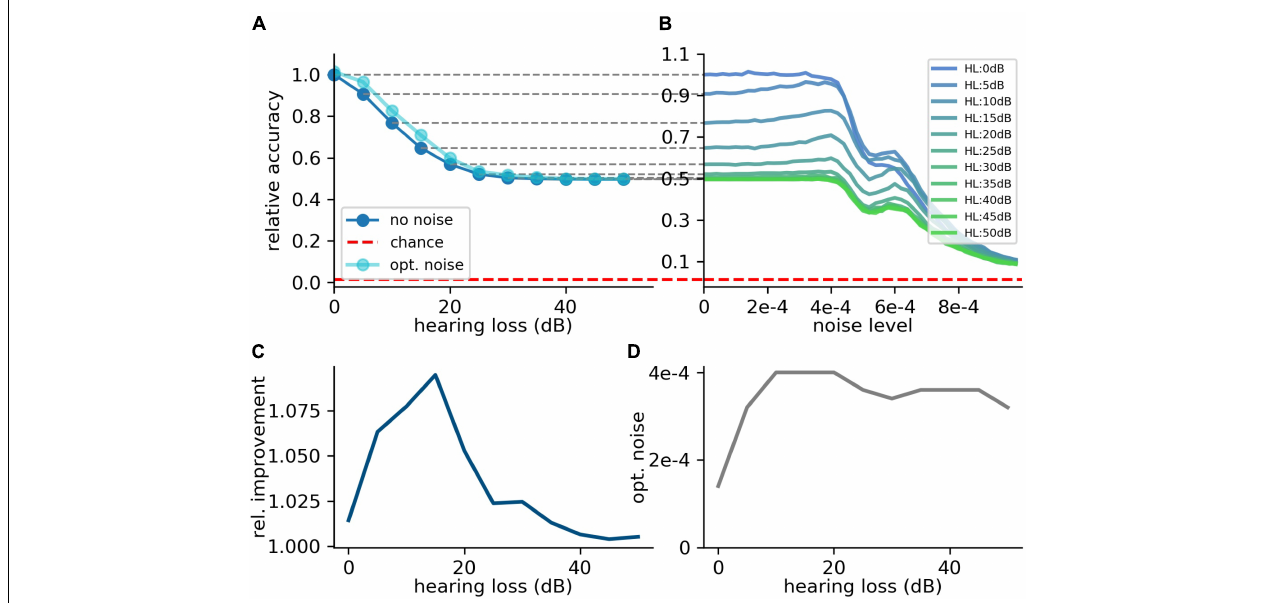
FIGURE 8 | Effect of SR on speech recognition (high frequency hearing loss). Same analysis as shown in Figure 7 for high frequency hearing loss. (A) The plots show the relative accuracy of the trained neural network as a function of the hearing loss (red dashed line: chance level). The high frequency hearing loss lead to different effects (10–50 dB, 10 dB steps, frequency range of HL: above 4,000 Hz). (B) The relative accuracy as a function of the noise has no clear maximum above the value for no added noise (nearly no SR). Furthermore, a second local maximum occurs. (C) The best relative improvement does not significantly increase over